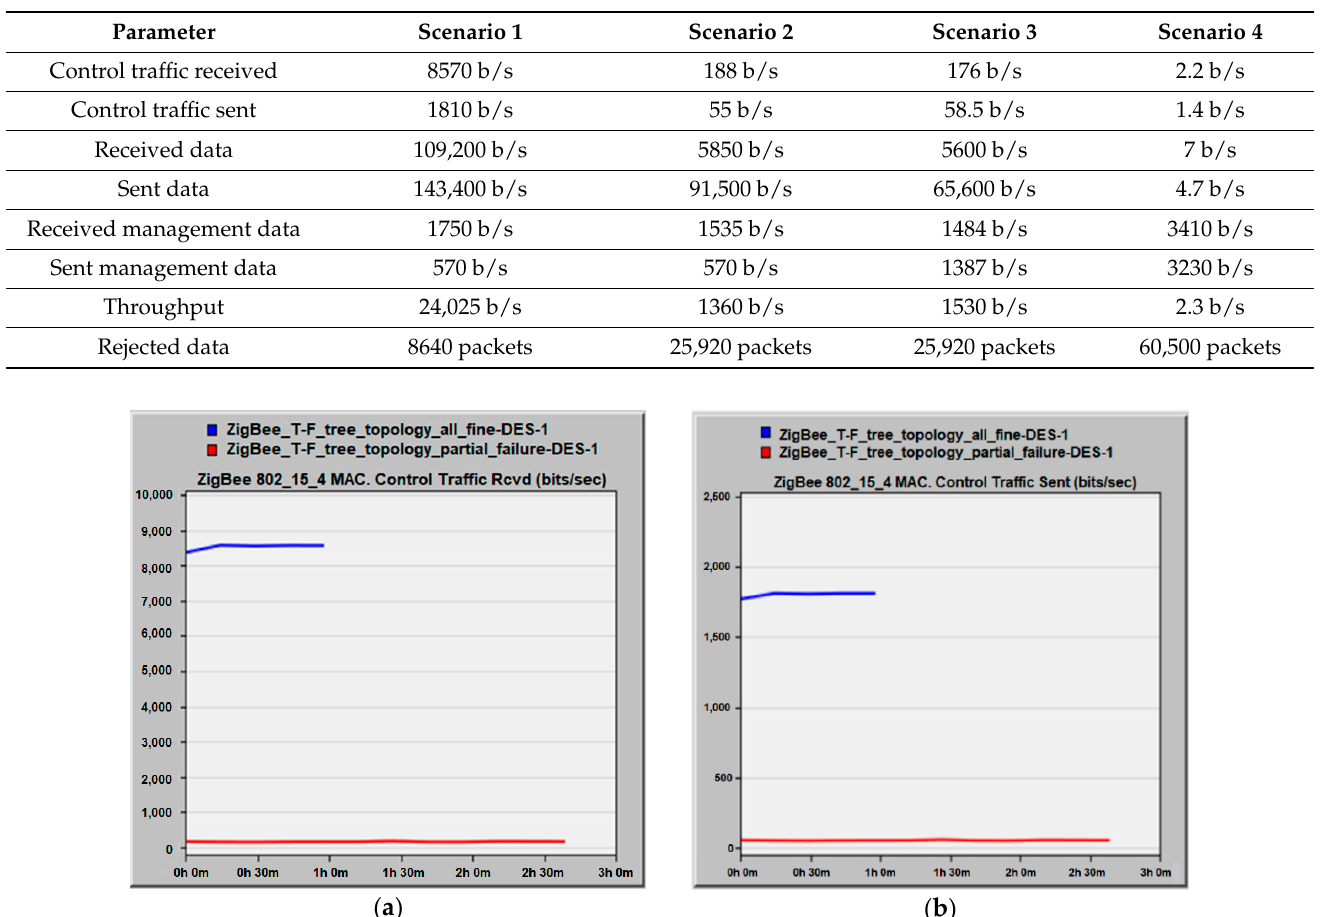
Table 5. The overall statistics of the network parameters in all scenarios.